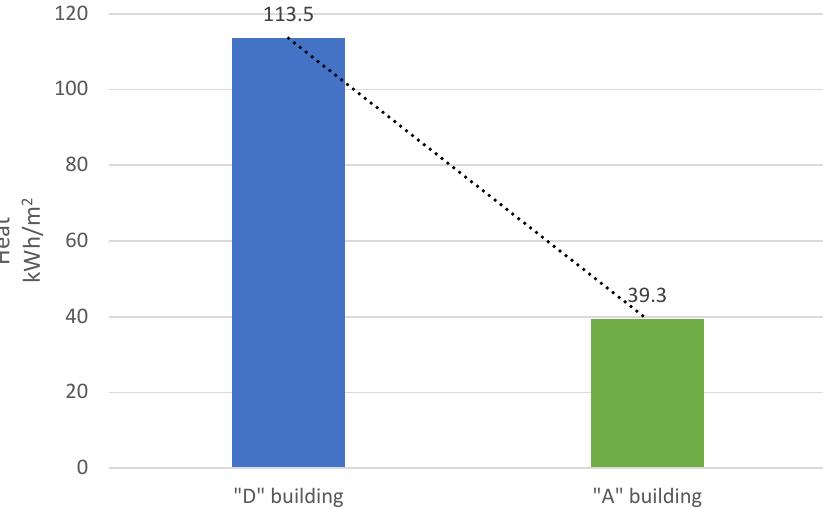
Figure 14. Heat energy consumption comparison .